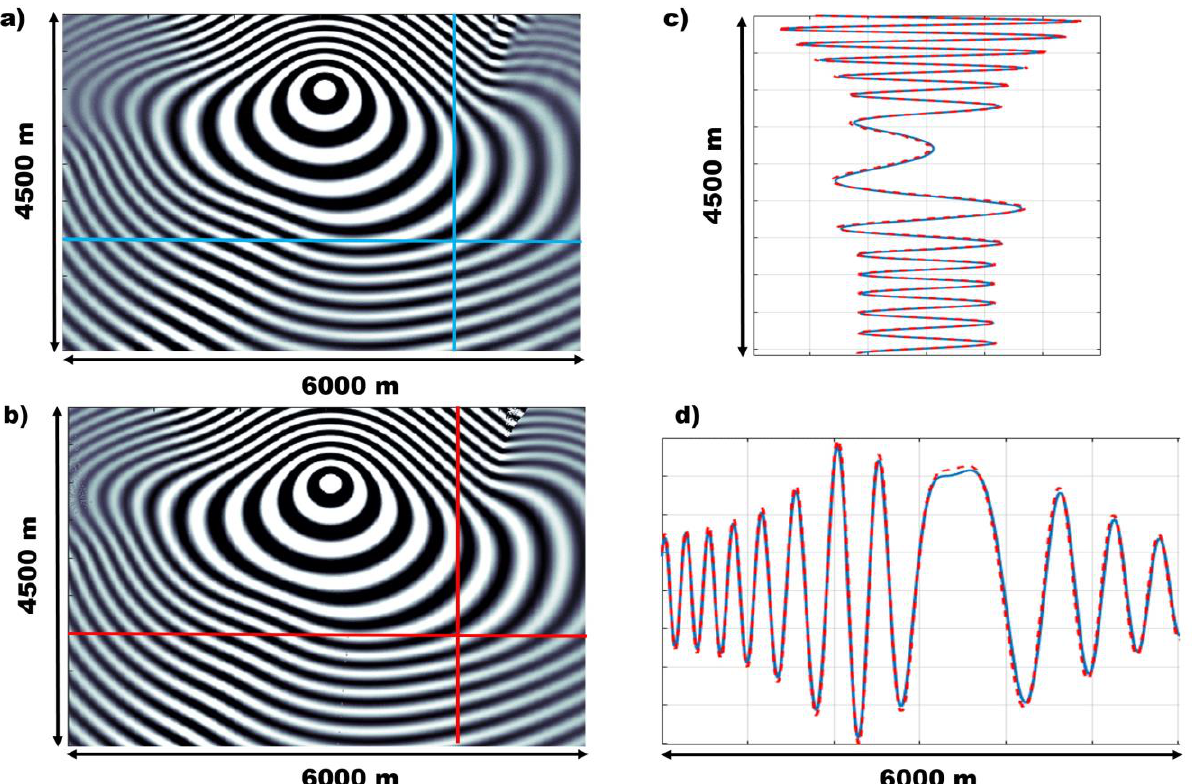
Figure 2. Wavefield in the frequency domain at a frequency of 10 Hz (real part): ( a ) finite difference modeling; ( b ) wave field in the ray approximation using Lomax rays; corresponding vertical ( c ) and horizontal ( d ) sections: (blue) finite difference method, (red) frequency-dependent Lomax rays. Table 1. Calculation times of wave field for one source on one processor core in the Sigsbee model and the error of the ray method relative to the result of finite difference modeling.